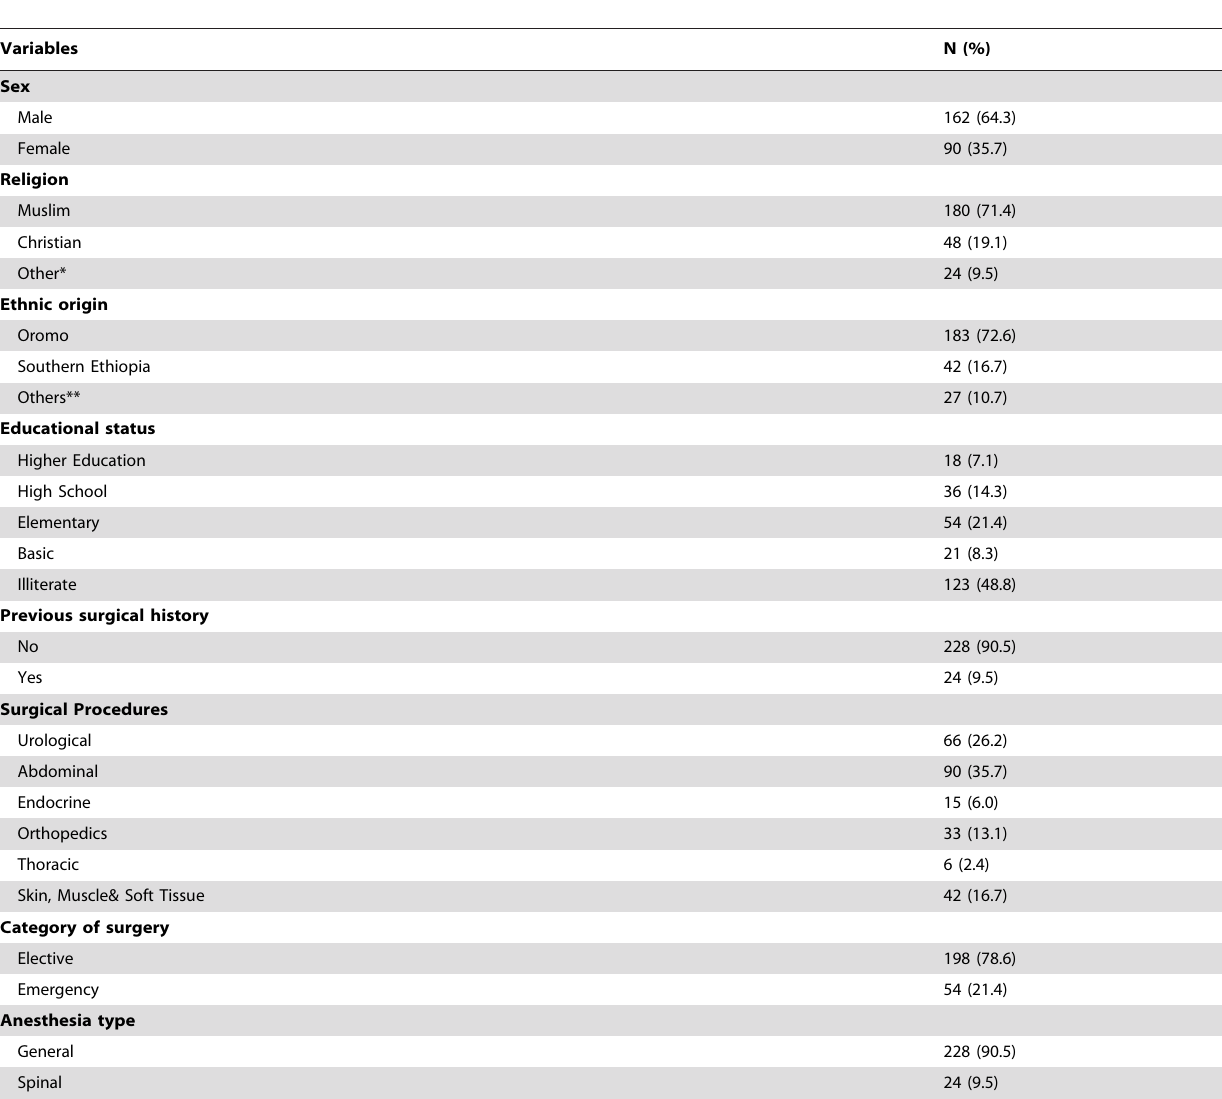
Table 1. Demographic and clinical characteristics of participants (n=